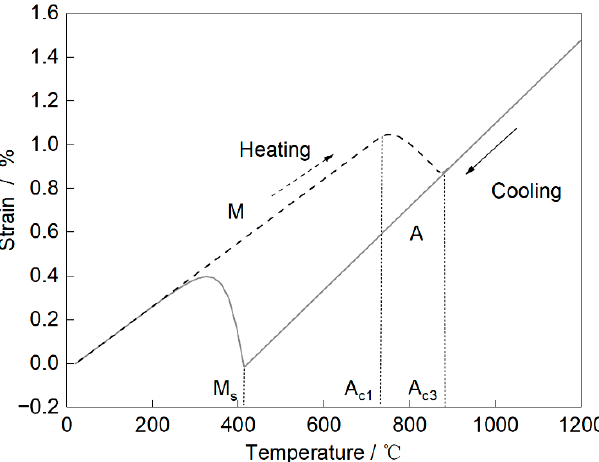
Figure 8. Temperature–strain curves of NM450TP steel during heating and cooling (M s —martensite transformation start temperature, A c1 —austenization start temperature, A c3 —austenization finish temperature).